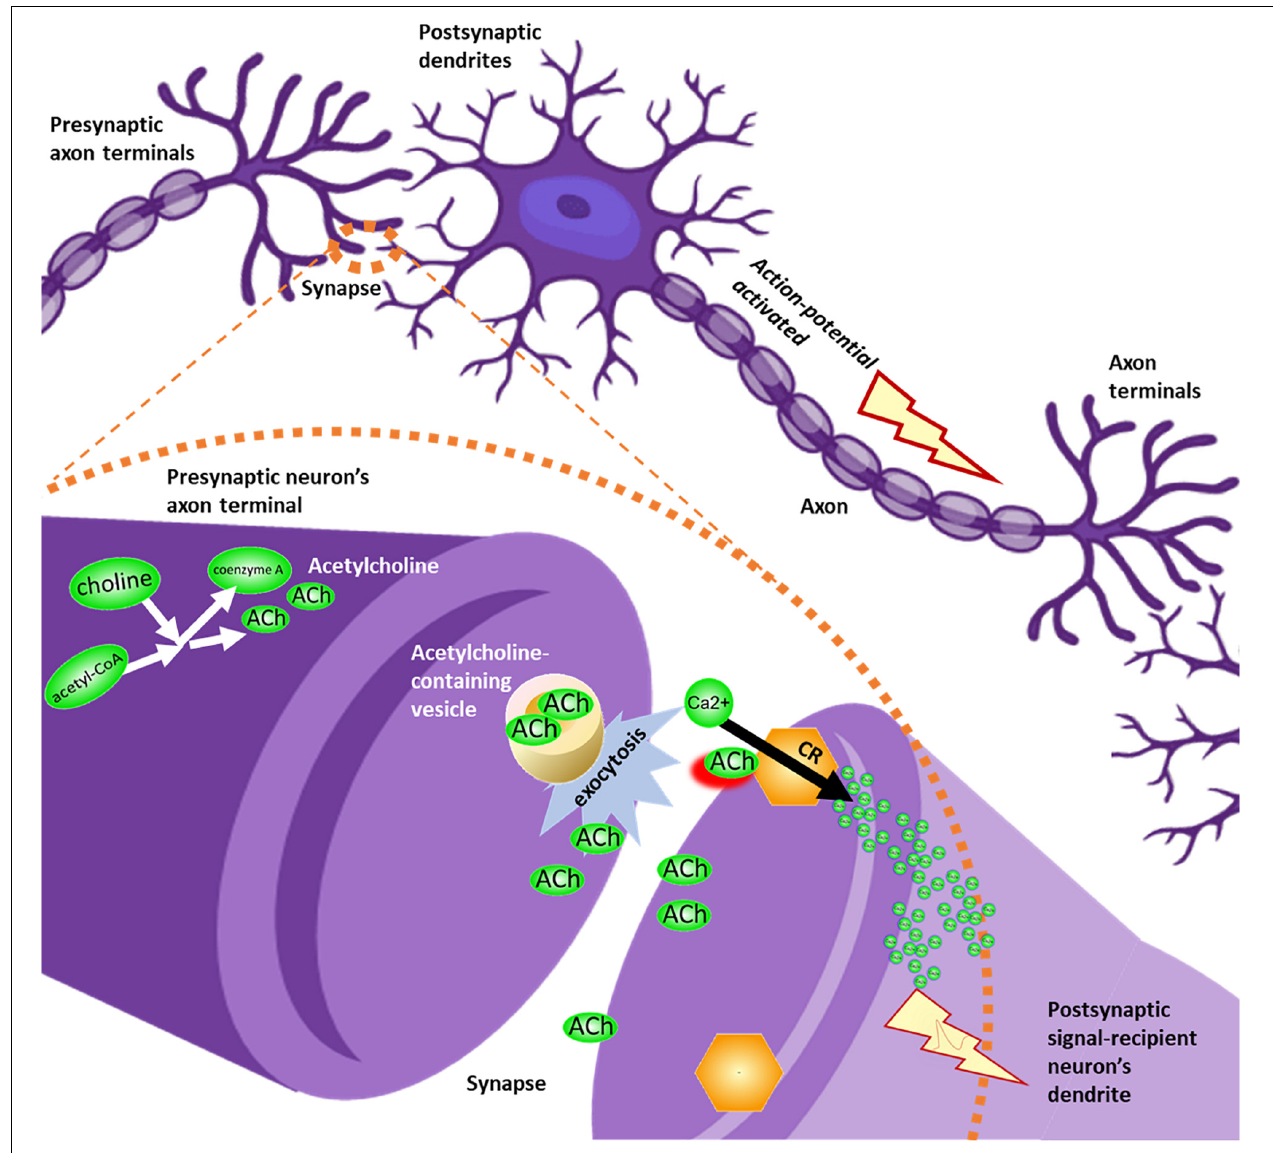
FIGURE 3 | Overview of acetylcholinergic signaling. Acetylcholine (ACh), sourced from precursors choline and acetyl-CoA, leaves the presynaptic neuron’s axon terminal through vesicle-mediated exocytosis. Acetylcholine molecules diffuse through the synapse, until binding with cholinergic receptors (CR) in the membrane of the postsynaptic signal-recipient neuron’s dendrite. This binding event permits influx of calcium ions into the dendrite. Ionic membrane depolarization activates an action potential, causing an electrical signal to be propagated down the length of the axon in a series of ion transport events, until the signal reaches the axon terminal and is translated again into neurotransmitter signals destined to reach the next neuron’s